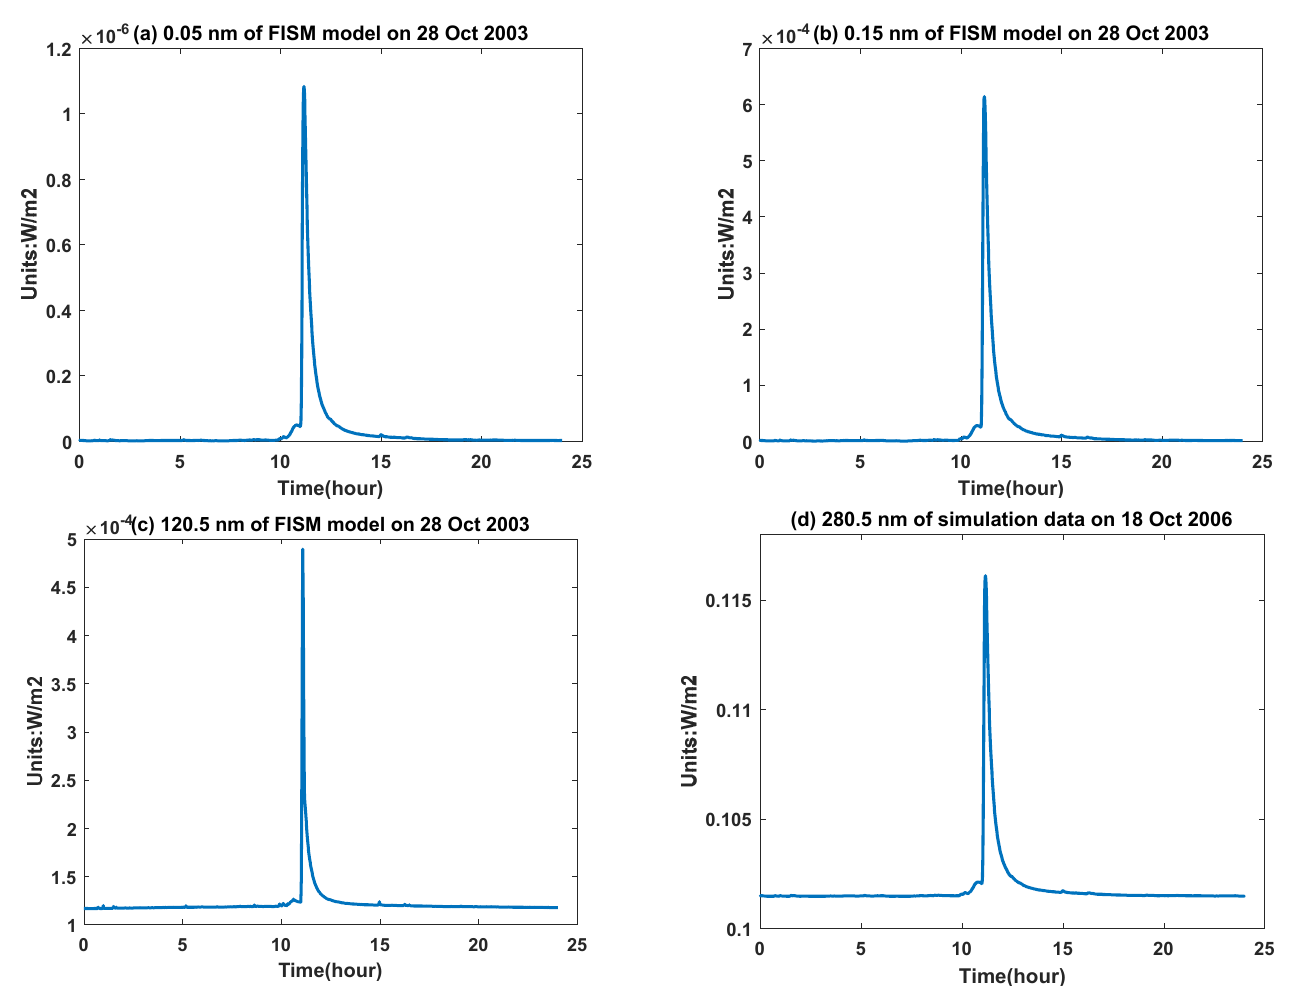
Figure 2. Input of various wavelengths for the simulation on 18 October 2006. (( a ) is 0.05 nm change of FISM data on 28 October 2003, ( b ) is for 0.15 nm, ( c ) is for 120.5 nm, ( d ) is the simulation data of 280.5 nm on 18 October 2006).